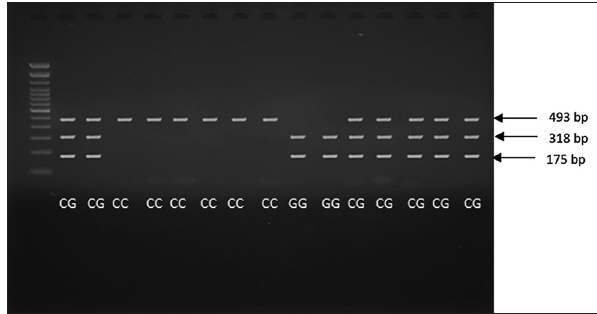
Figure-4: Melanocortin-4 receptor gene polymerase chain reaction-restriction fragment length polymorphism with HpyCH4IV restriction